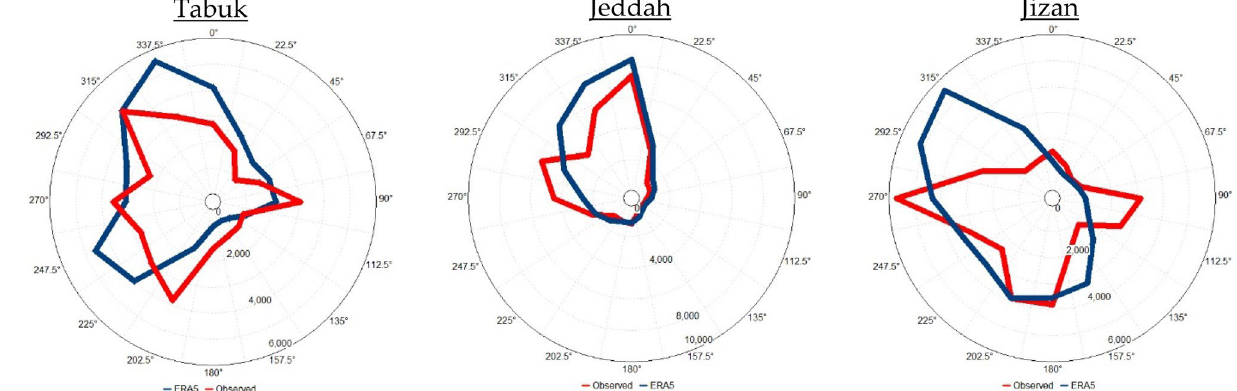
Figure 5. Observed (ERA5) annual wind rose diagram based on hourly observed (ERA5) data from 2016 to 2020 in Tabuk, Jeddah and Jizan. The blue colour indicates the observations, while the red colour indicates the ERA5 data. UL, Inc. Windographer professional edition version 5.0.5. https:// www. ul. com/ resou rces/ apps/ windo graph